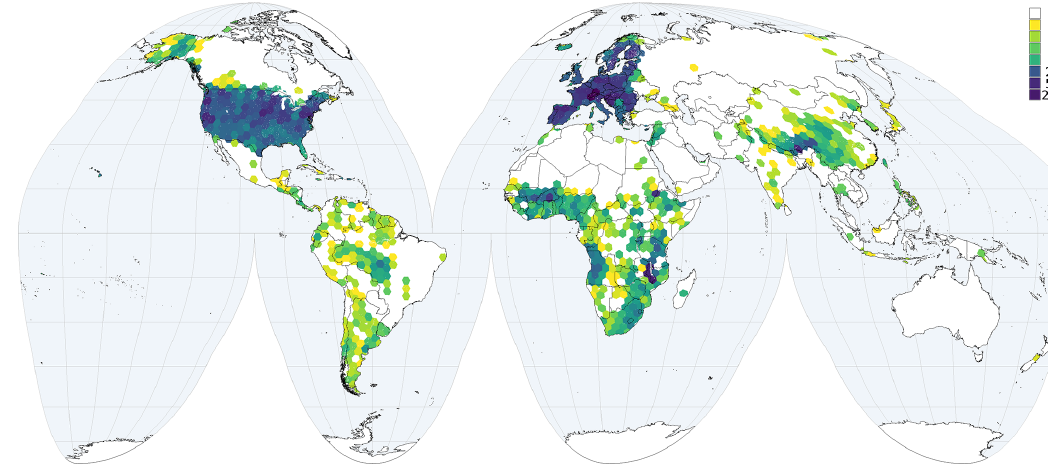
Figure 4. Number of observations per grid cell (70000km 2 ) for coarse fragments.